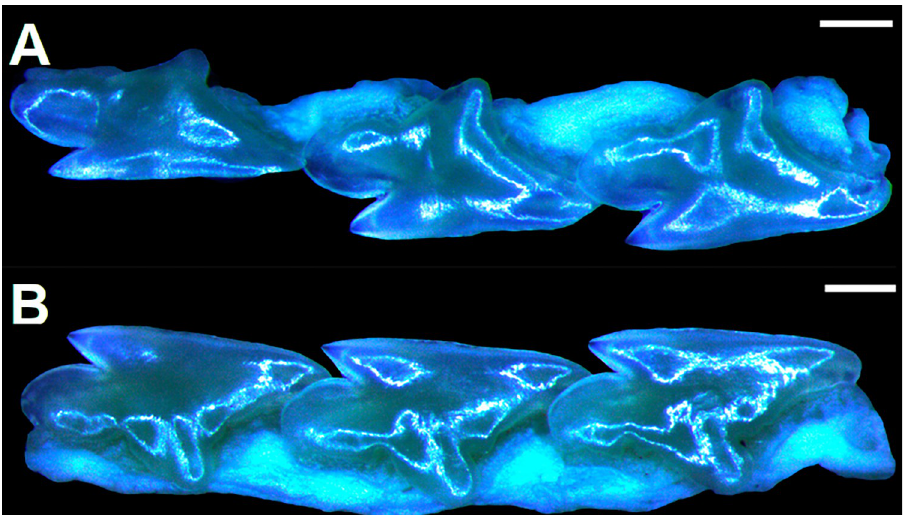
Fig 17. Upper (A) and lower (B) teeth of C . barbifer , NMW 98257, adult female, 960 mm TL (labial view). Scale bars: 1